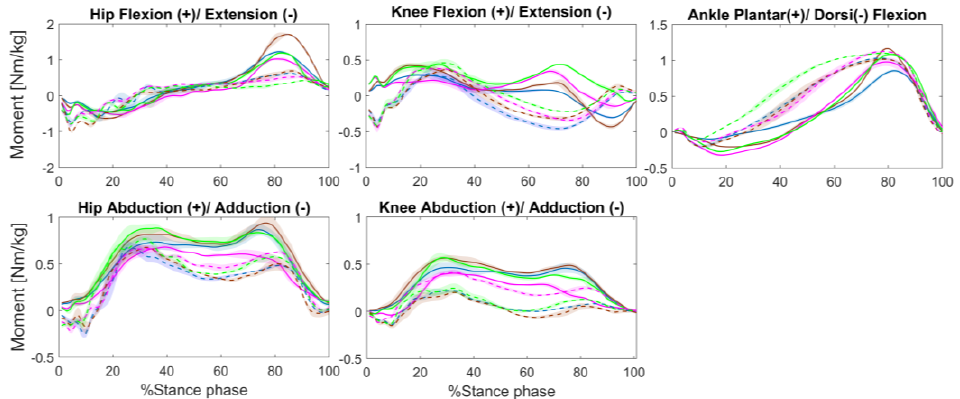
Figure 4. Joint moment means waveforms for four prosthetic conditions subject groups: Variflex (blue), Meridium (brown), Echelon (magenta), and Kinterra (green). The kinematic of the amputated leg is presented in a continuous line, and that of the unaffected leg is presented in a dotted line. The shaded region denotes the standard deviation.